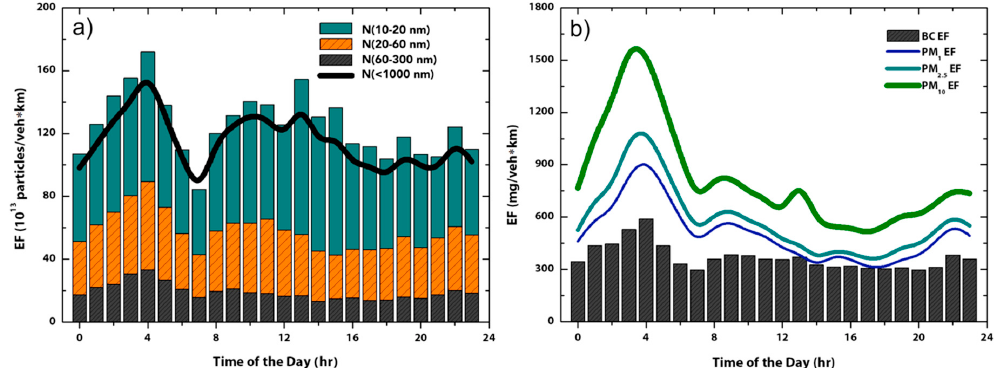
Figure 4. The average diurnal variation of ( a ) size-segregate particle number (PN) and ( b ) particle mass emission factors for a mixed fleet in Manila.